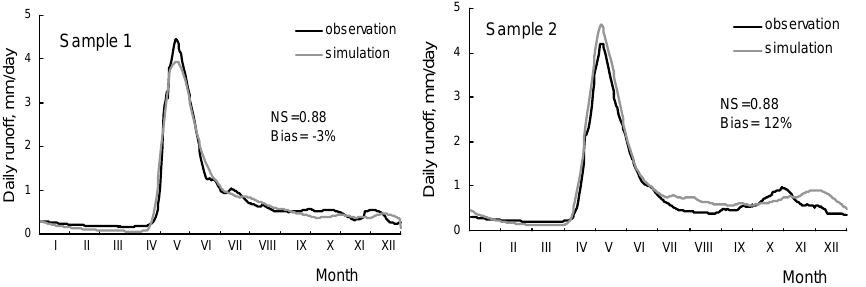
Figure 2. Comparison of measured and simulated by SWAP hydrographs of daily runoff for the Northern Dvina River averaged over the Sample 1 (calibration) and Sample 2